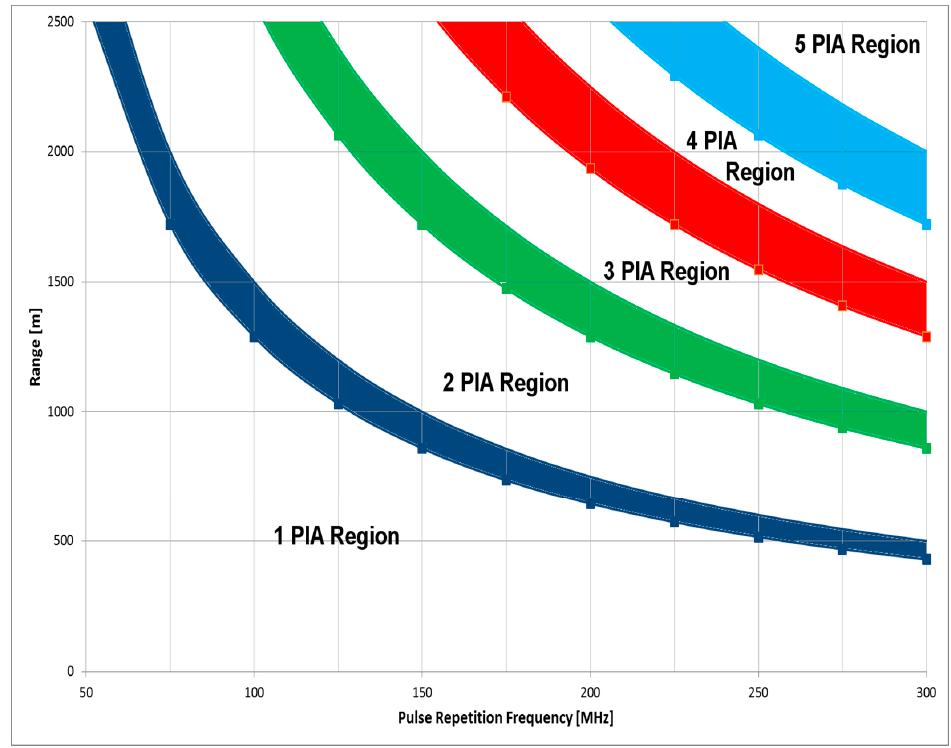
Figure 2. Pulse repetition frequency (PRF) versus range operation regions for NCALM’s Titan sensor. The graph shows both regions of operation ( white ) as well as range ambiguity regions depicted as the solid colored bands.